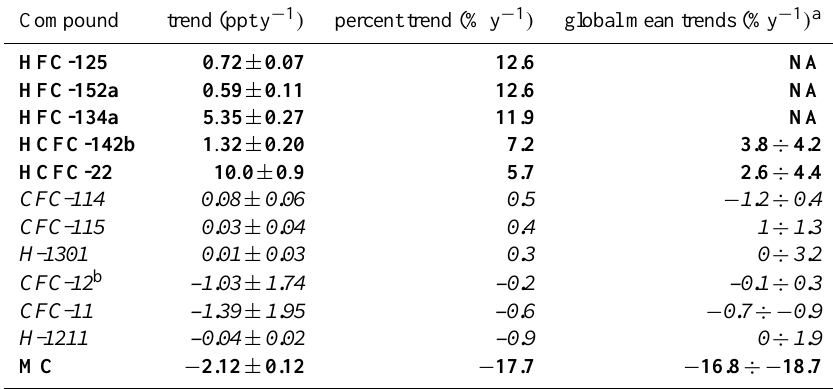
Fig. 4. Ratios of the occurrence of high concentration values at MTC with respect to NCO-P. Chemically homogeneous classes of compounds are denoted by identical shading. Table 4. Absolute and percent atmospheric trends of HCs after three years of observations at